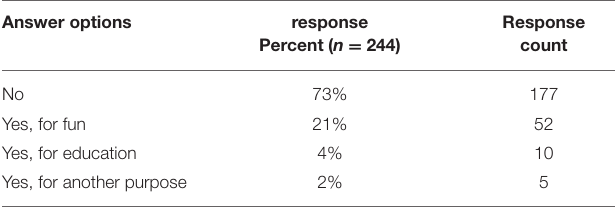
TABLE 1 | Previous experience with virtual